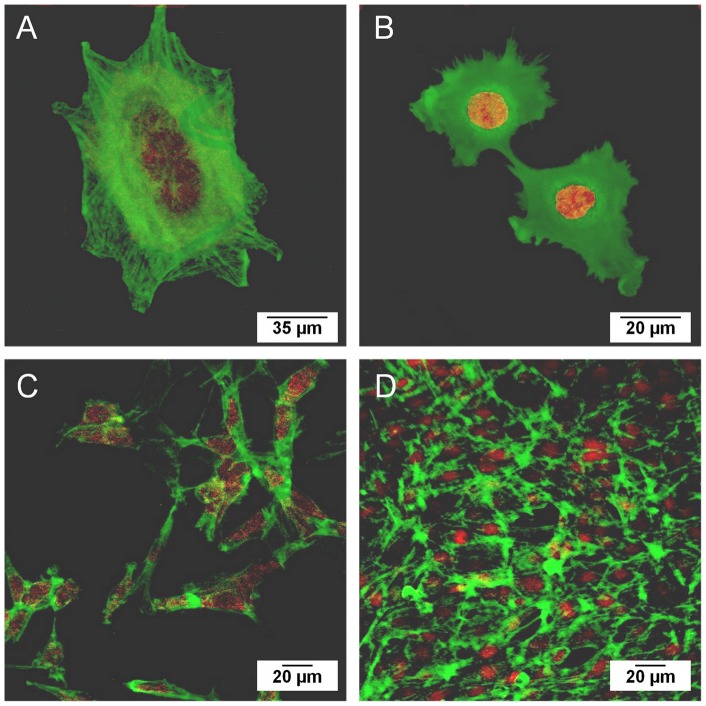
Confocal images of fibroblasts proliferated.(A) 2 days on chitosan-coated surface. (B) 2 days on titanium surface. (C) 4 days on chitosan-coated surface. (D) 7 days on chitosan-coated surface. Actin filaments (green) and nuclei (red) were stained.